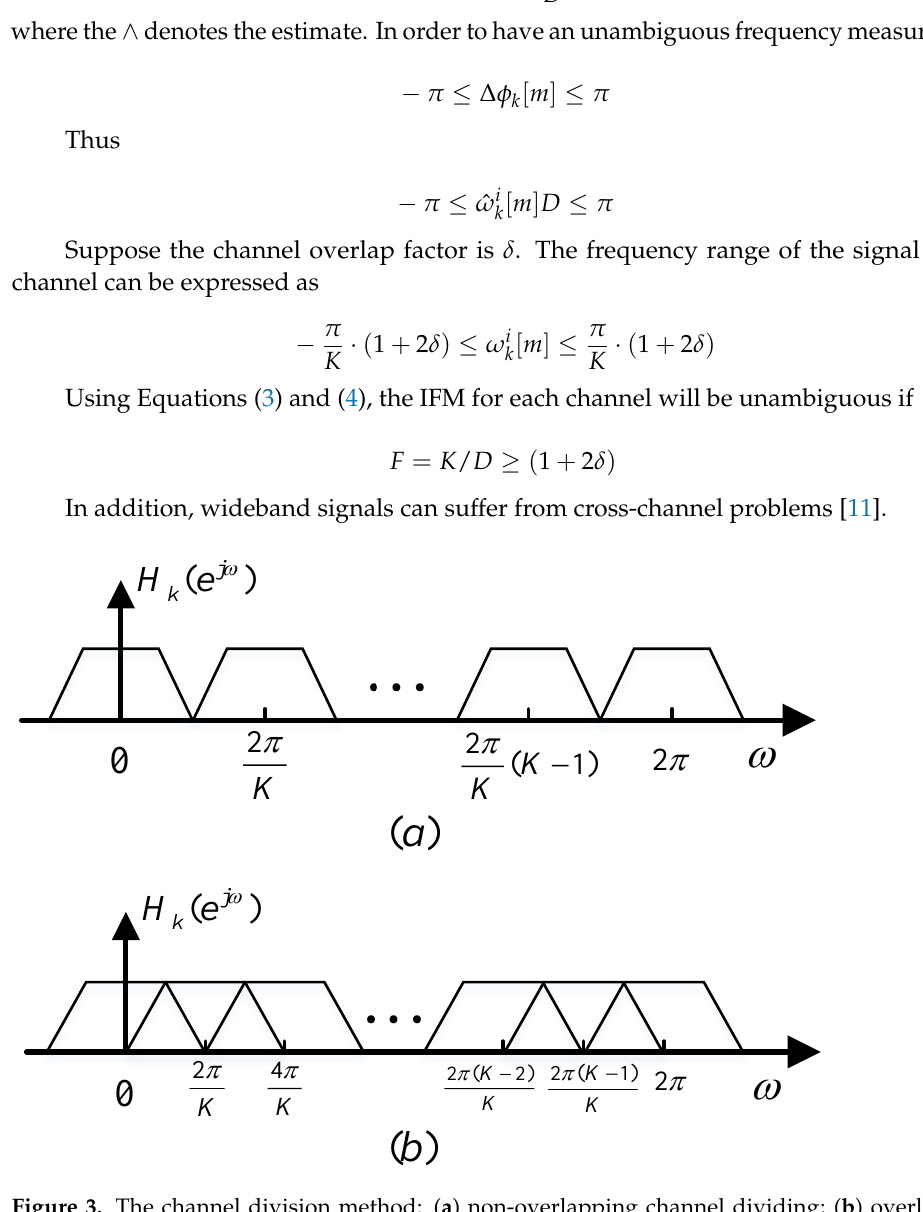
Figure 3. The channel division method: ( a ) non-overlapping channel dividing; ( b ) overlapping channel